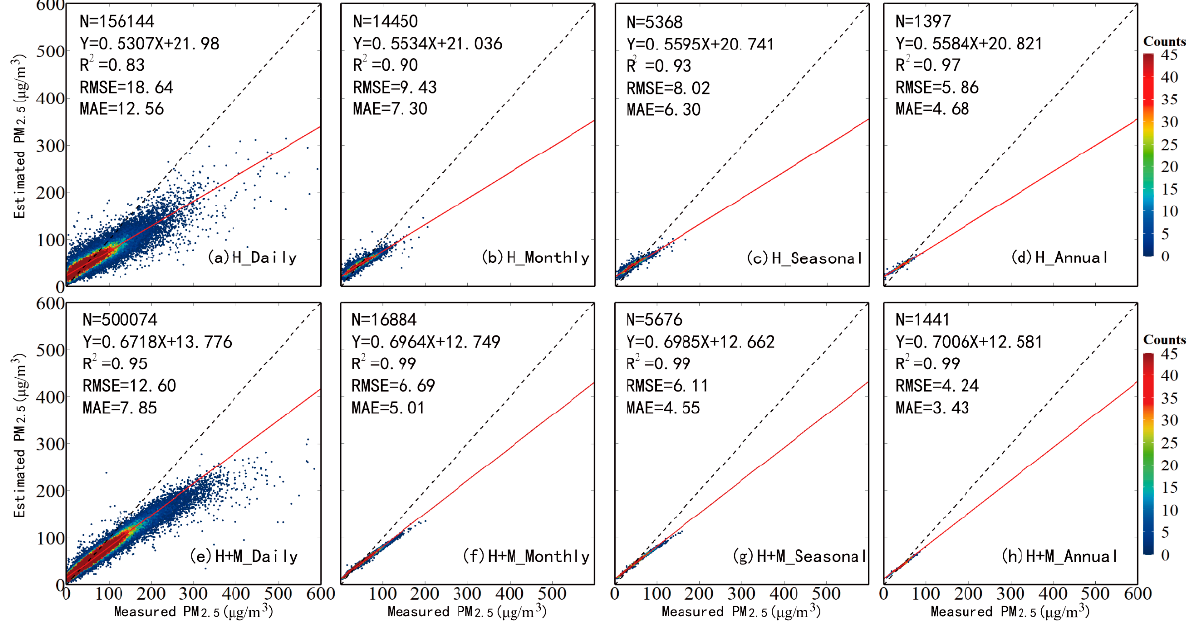
Figure 5. Density scatterplots of cross-validation result of hourly PM 2.5 estimates derived by AODH and AODH+M, respectively, for ( a , e ) daily, ( b , f ) monthly, ( c , g ) seasonal, ( d , h ) annual.